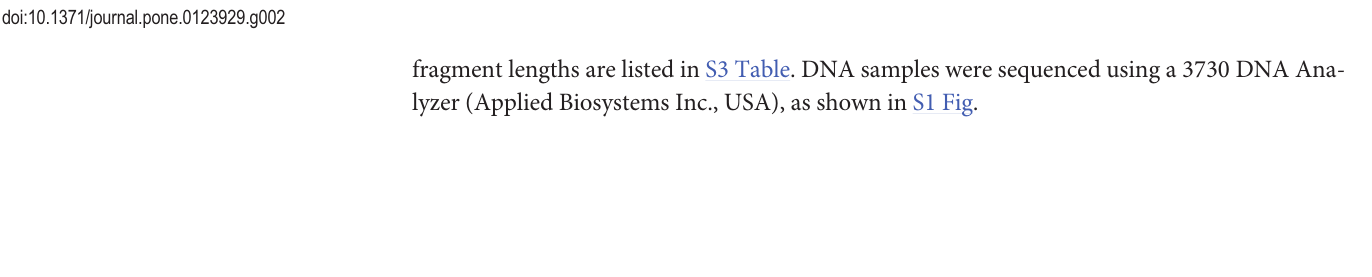
Fig 2. Haplotype block and LD structure for SNPs in Chr15: 89631381 – 89745591 in Chinese Han Beijing